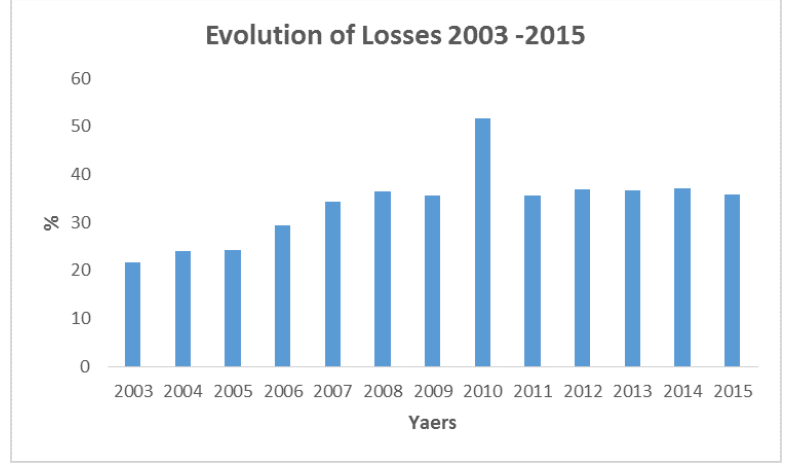
Figure 5. Evolution of Santiago Island electrical